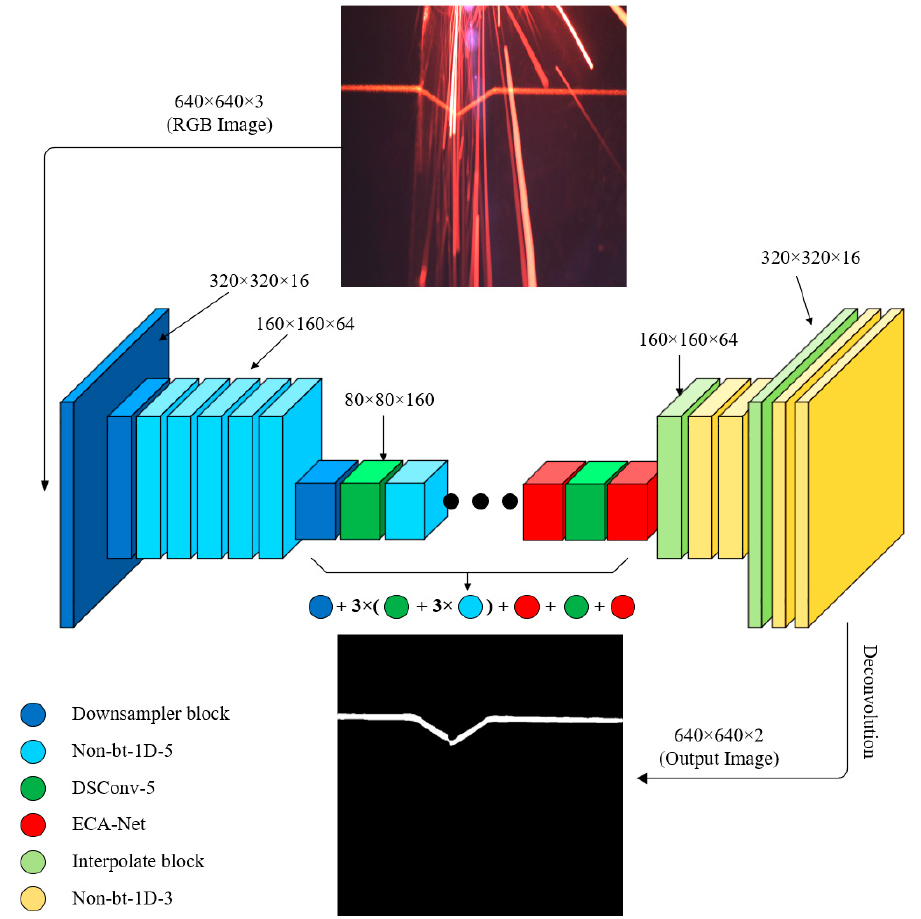
Figure 5. Overview of network architecture for end-to-end training.